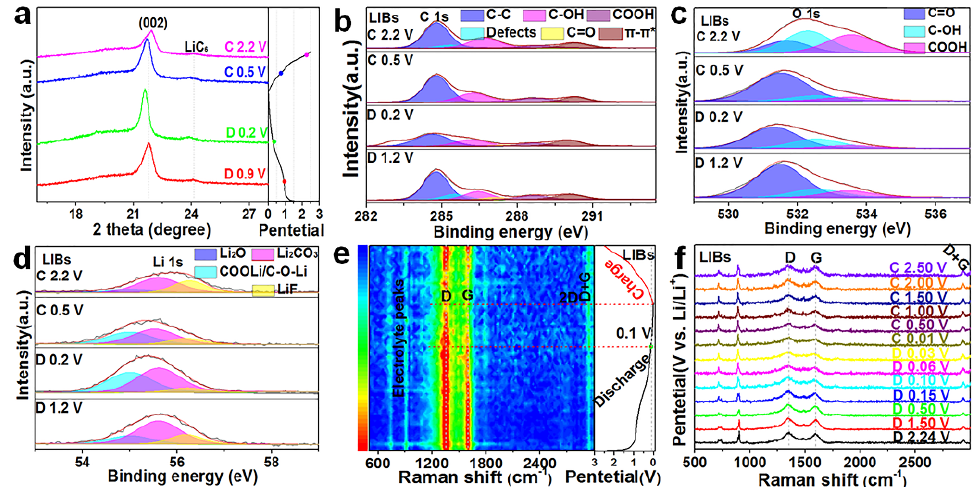
Figure 4. Electrochemical performance characterization of the three electrode materials in LIBs. ( a ) Ex situ XRD of C − 1000 H 2 − 600 at varying discharge/charge voltages. Ex situ XPS spectra of ( b ) C 1s, ( c ) O 1s, and ( d ) Li 1s in LIBs for C − 1000 H 2 − 600 at varying discharge/charge voltages. ( e ) In situ Raman mapping and ( f ) the corresponding spectra of C − 1000 H 2 − 600 during the first discharge/charge process.